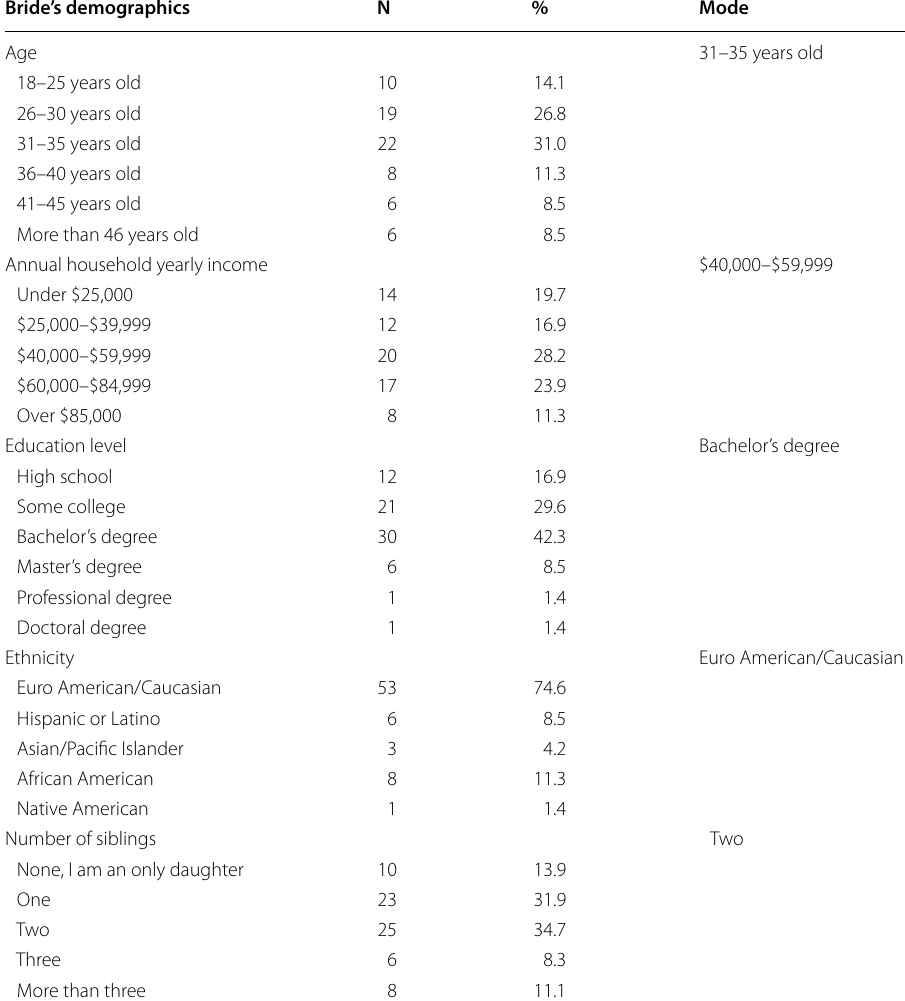
Table 2 Participants’ demographics (n